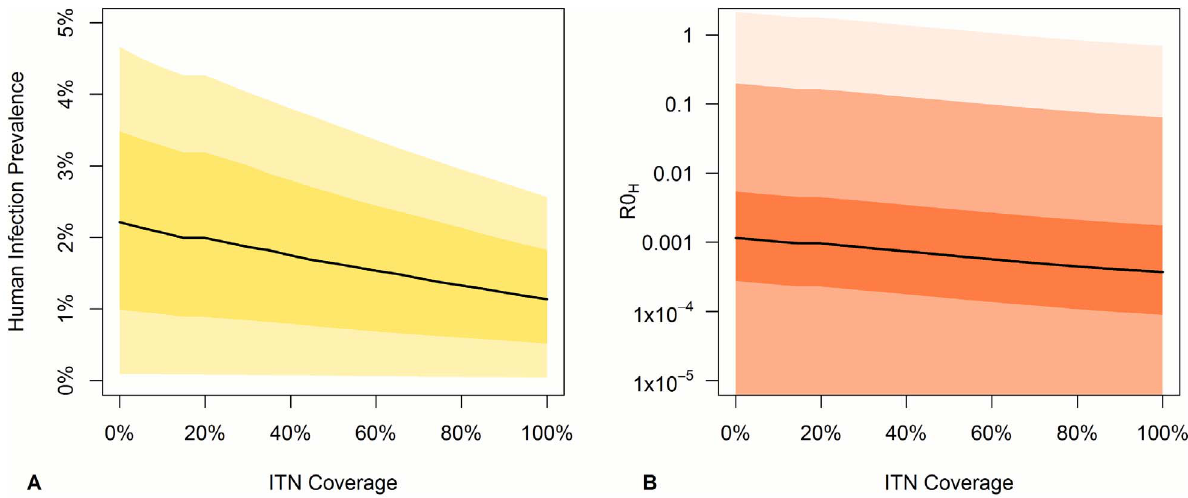
Figure 3. Change in a) total human infection prevalence and b) human R 0 (R 0H ) with increasing LLIN/LLIH coverage in the village and jungle areas. Shaded areas represent for: (a) the 95% range (light yellow) and the interquartile range (dark yellow), (b) the full range (light pink) to enable us to see the coverage needed to bring R 0H below 1, the 95% range (light red), and the interquartile range (dark red). The block line represents the median value.